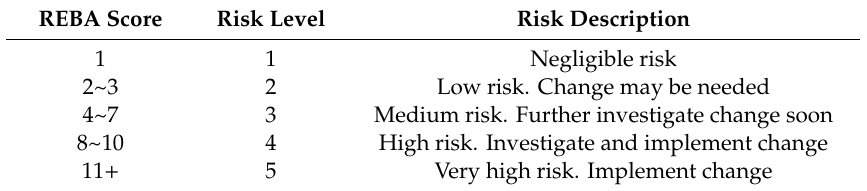
Table 1. Rapid entire body assessment (REBA) grand scores, risk levels, and grade